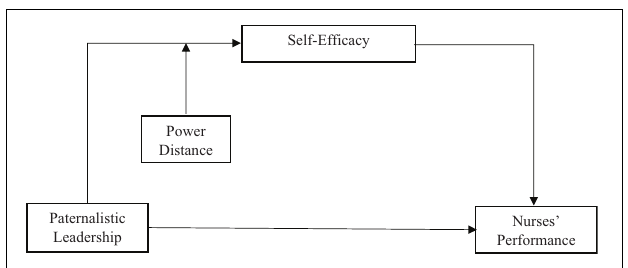
FIGURE 1 | Proposed theoretical